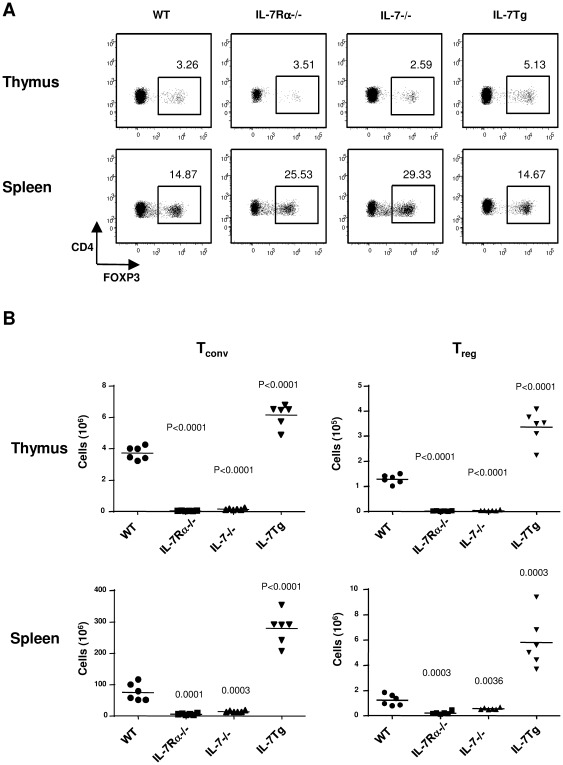
IL-7 signaling is involved in both thymic development and peripheral maintenance of Foxp3+ Treg.(A) Representative dot plots of FOXP3 expressing cells gated on CD4+ CD8− TCRβ+ thymocytes and splenic CD4+ TCRβ+ cells from normal B6, IL-7Rα−/−, IL-7−/− and IL-7 Tg animals. Numbers in each dot plot indicate the relative percentages of FOXP3 cells among CD4+ T cells for representative animal selected among 4 to 6 mice per group. (B) Absolute numbers of CD4+ FOXP3+ T cells from normal B6, IL-7Rα−/−, IL-7−/− and IL-7 Tg animals. Each point represents a single mouse and mean values are indicated for each groups. Experiments were repeated independently twice with four to six mice per group; the data shown are representative of one experiment. The degree of statistical significance (p values), relative to normal B6 numbers, is indicated.